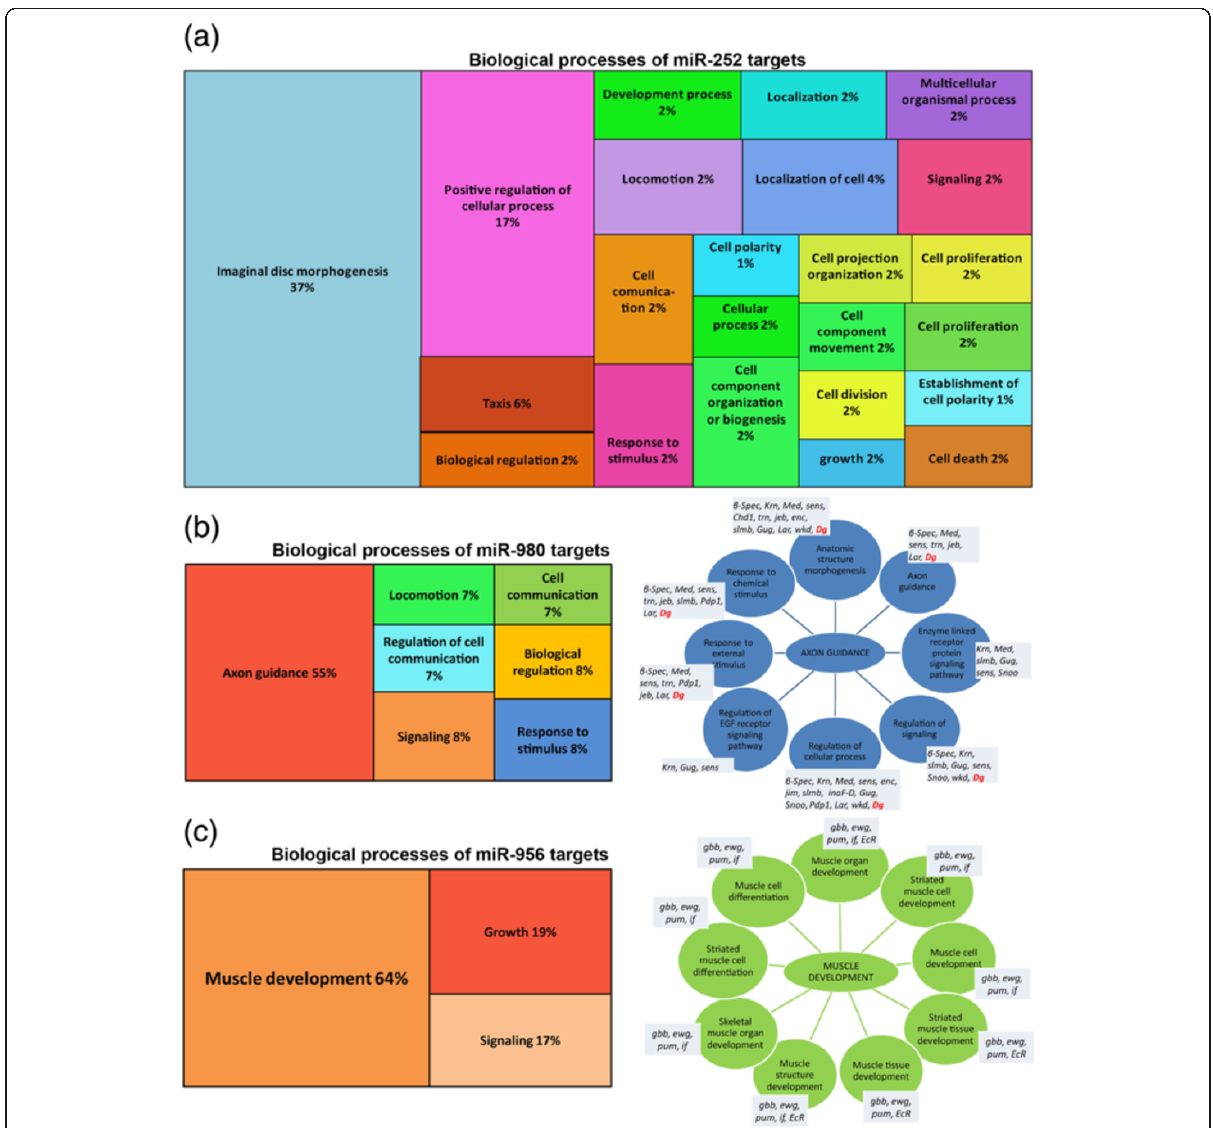
Figure 4 Dg-Dys-Syn1 regulates levels of miRNAs with diverse mRNA targets. Gene ontology predictions of putative ( a ) miR-252, ( b ) miR-980 and ( c ) miR-956 target genes. ( a ) The majority of miR-252 targets are involved in imaginal disc morphogenesis next to regulation of cellular process. ( b ) More than half of the putative miR-980 targets are involved in processes essential for axon guidance, whereas the majority of miR-956 targets are involved in muscle development. Percentages are based on the number of target genes involved in the shown process where predictions are based on a p ≤